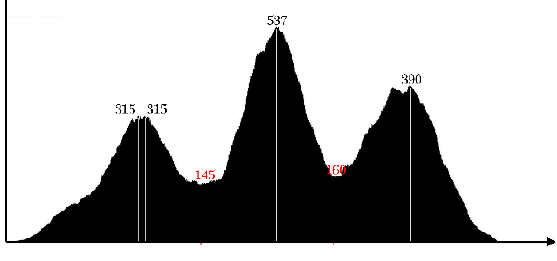
Figure 11. Detection intensity histogram